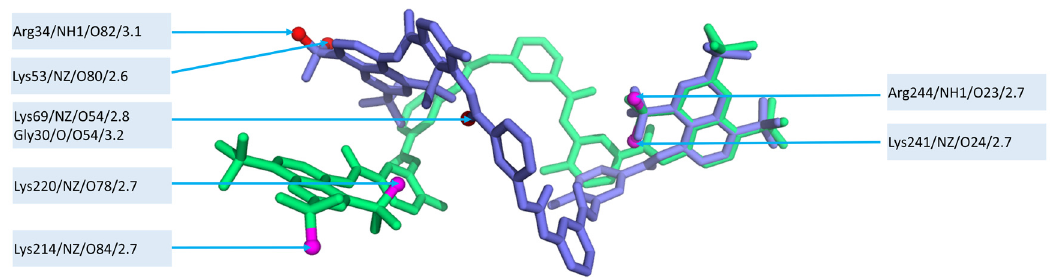
Figure 5. Different conformational changes in the suramin molecule on binding to different proteins. Suramin molecules bound to heparin-binding site of a complement control protein from Vaccinia virus (poxvirus, PDBid:1Y8EA, in green) and the myotoxin II from Bothrops asper (venomous pit viper, PDBid:1Y4LB, in blue) shows the different conformational changes induced in the drug molecule upon binding. This significantly increases the conformational space to be sampled by computational docking methods. Different atoms of SVR are involved in the ligand binding for different proteins, although these are predominantly positively charged residues (SVR:PDBid:1Y4LB in red, SVR: PDBid:1Y8EA in mageneta).